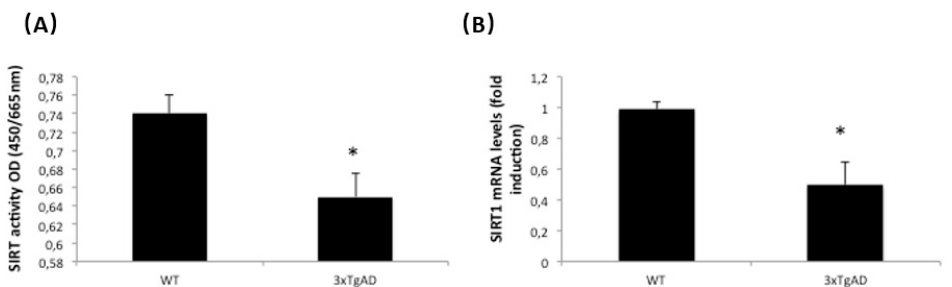
Figure 4. Sirtuins are regulated in APP/BIN1/COPS5 3xTg-AD mice. ( A ) Sirtuin activity was measured as indicated under Materials and Methods . ( B ) SIRT1 mRNA levels were measured by qPCR in samples from both wild-type ( n = 4) and APP/BIN1/COPS5 3xTg-AD ( n = 4) mice. Data are expressed as mean ± S.E.M; * p < 0.05. OD, optical density, SIRT, sirtuin.